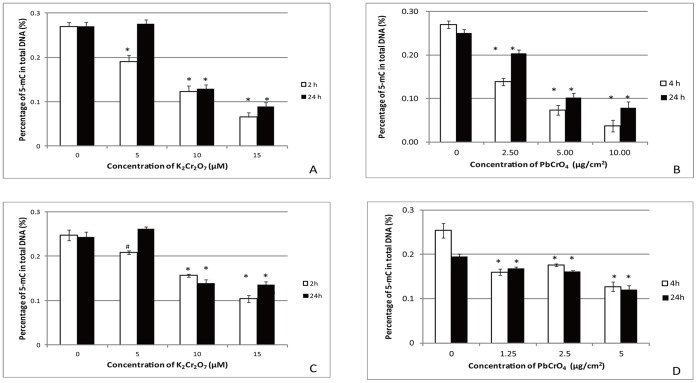
Global hypomethylation induced by Cr (VI) in two cell lines.A and C: Percentages of 5-methyl-cytosine (5-mC) in DNA extracted from human B lymphoblastoid cells (A) and from A549 cells (C) treated with potassium dichromate for 2 hours and 24 hours. B and D: Percentages of 5-methyl-cytosine (5-mC) in DNA extracted from human B lymphoblastoid cells (B) and from A549 cells (D) treated with lead chromate for 4 hours and 24 hours. Asterisks above the bars indicate that the difference between exposure and control was significant (P<0.01).